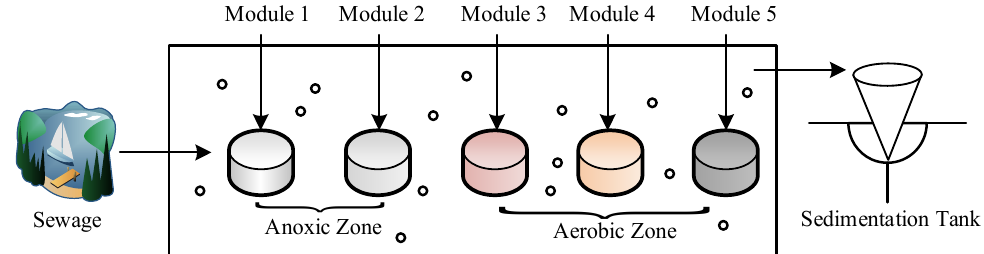
Figure 2. Sewage treatment control system structure diagram.